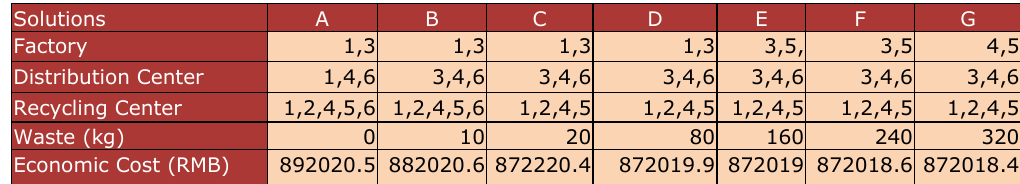
Table 4. Site-Selection Results in Pareto Solution